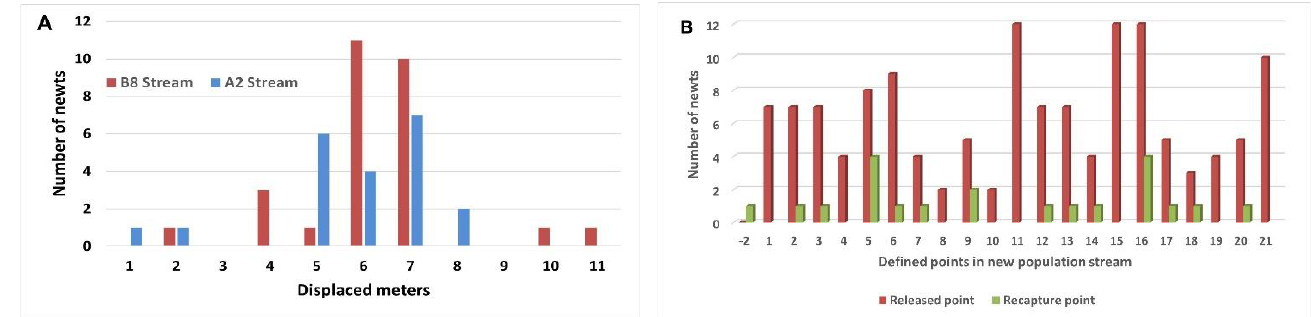
Figure 11. ( A ) Displacements observed for the newly released individuals in a newly created population (A8) in the first year and in the wild population (A2). Horizontal axis represents the number of displaced meters from release to recapture. The positive values indicate upstream displacements and negative values indicate downstream displacements. ( B ) Distribution of newly released newts in the stream B8 and the recaptures during the first year after release. Red bars indicate the release point and green bars the recapture point.